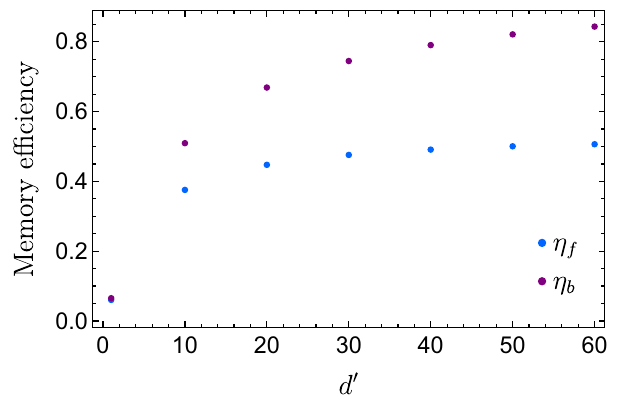
FIG. 6. Maximum free-space ATS memory efficiency for for- ward ( η f ) and backward ( η b ) retrieval with respect to the effective optical depth in the broadband